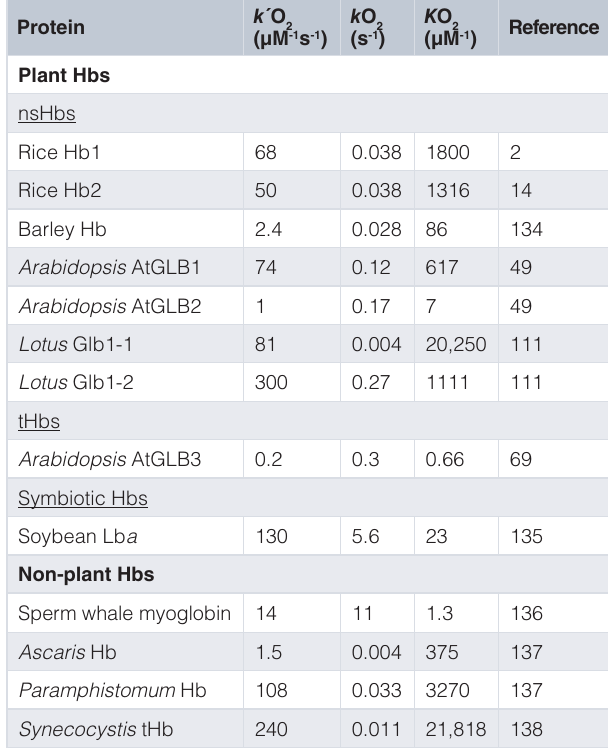
Table 2. Rate and equilibrium constants for the reaction of O from rice Hb1 and 2. Constants for arbitrarily selected plant and non-plant Hbs are included for